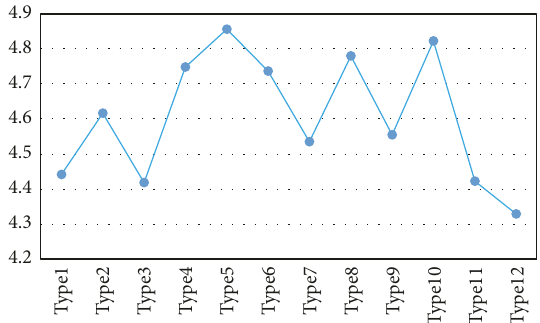
Figure 10: The robustness value for different merging